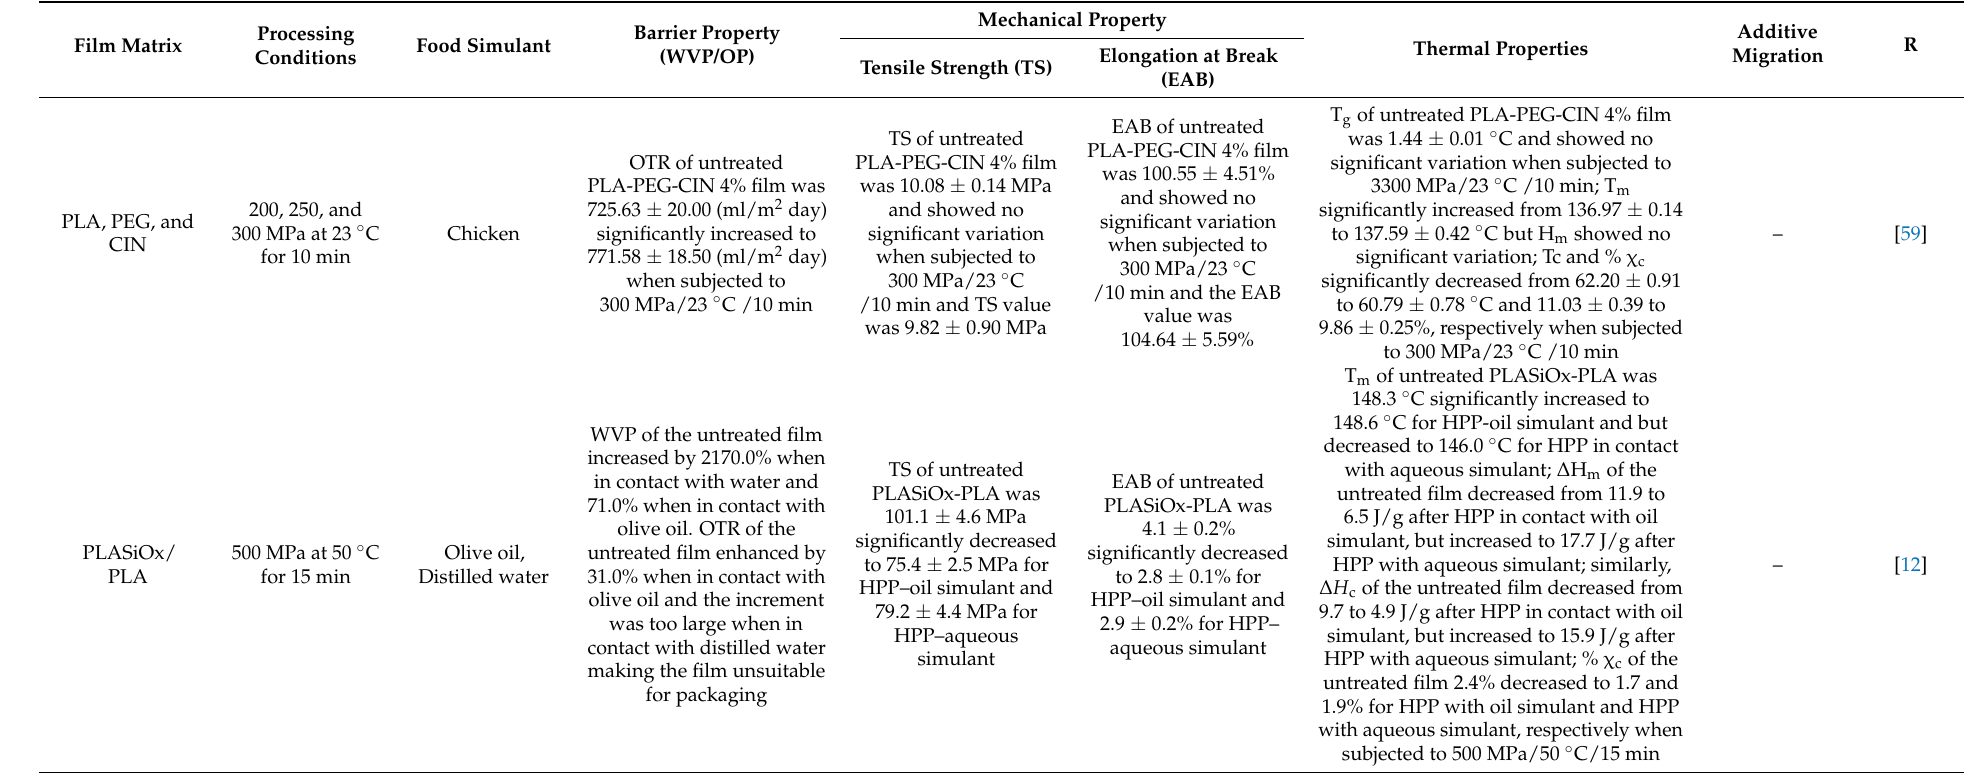
Table 2. Effect of HPP on the physical properties of the biopolymer-based